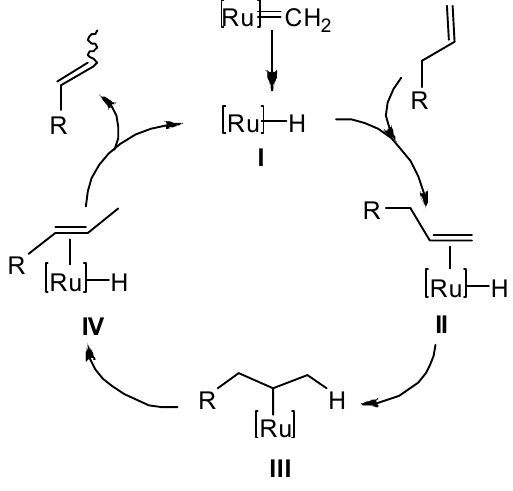
Scheme 9. Plausible mechanism for isomerization of terminal olefins to internal olefins (adapted from ref. [4]).